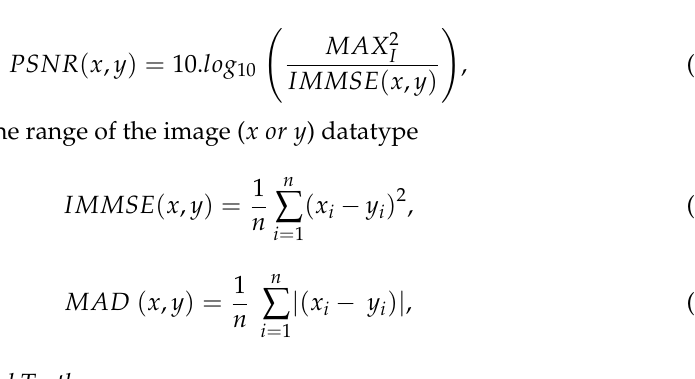
Figure 8. Quasi-ground truth of SRD.